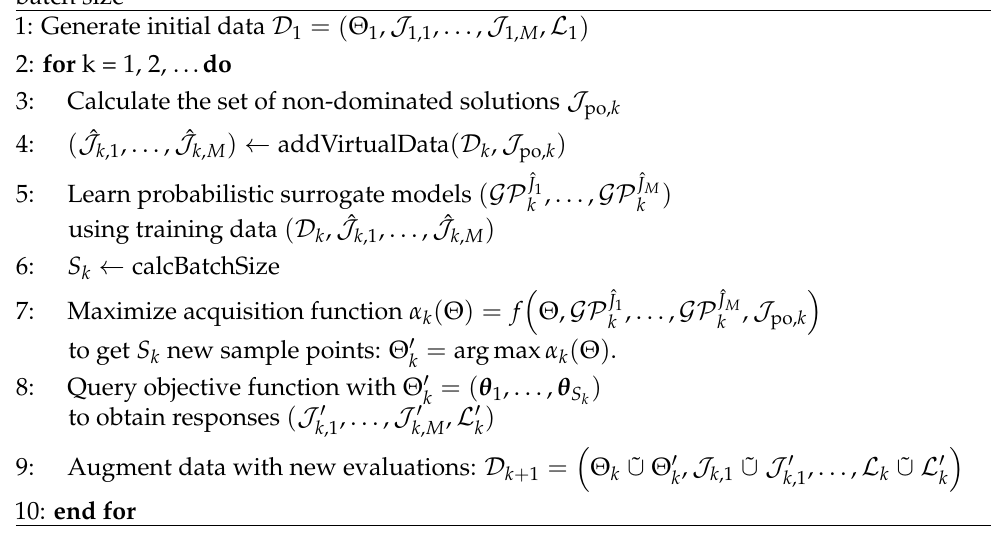
Algorithm 1 Multi-objective Bayesian optimization with crash constraints and flexible batch